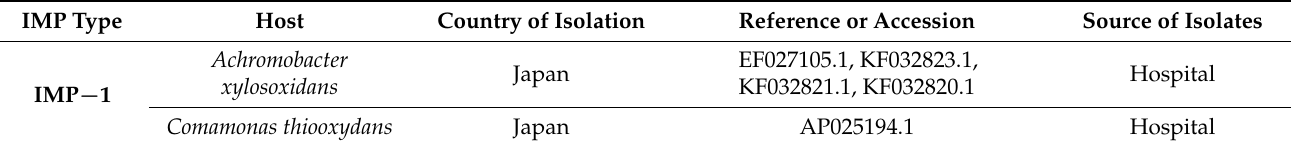
Table 1. List of currently available IMP-type metallo- β -lactamase